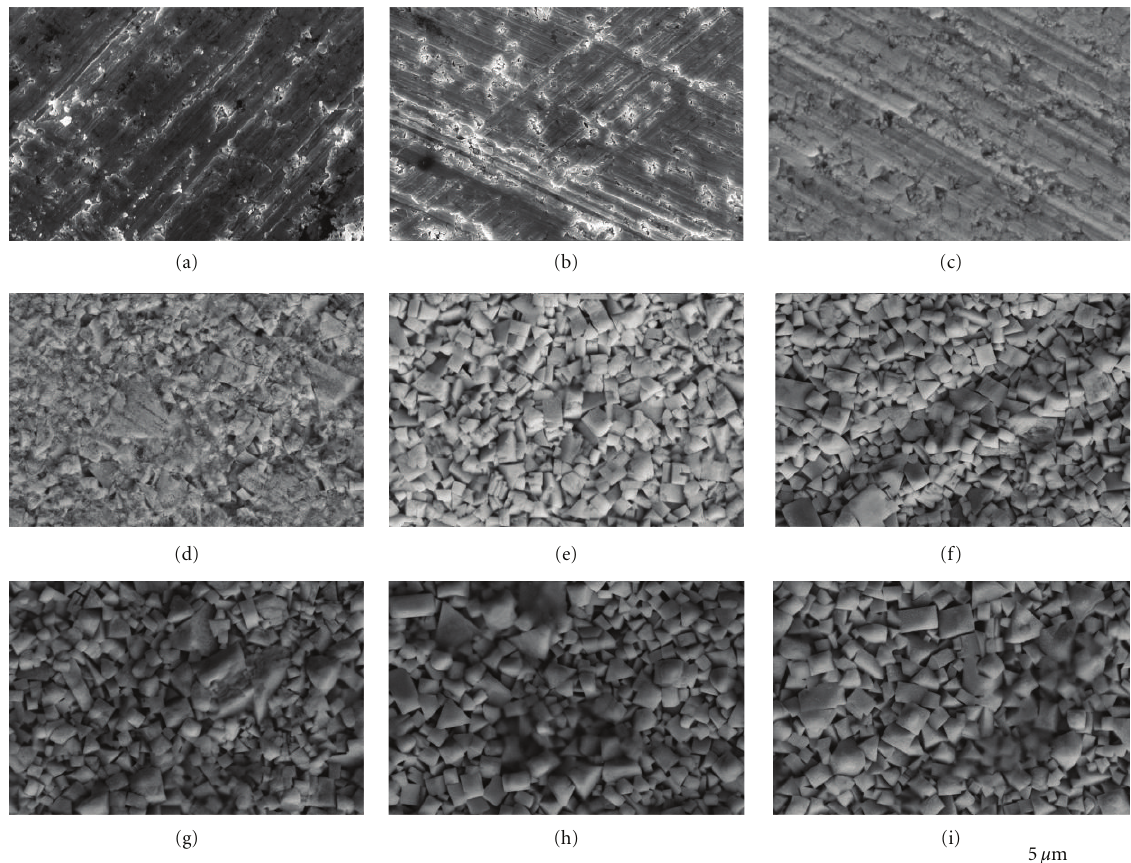
Figure 9: WC-Co substrate after and before laser processing: (a) as-received, (b) 600W, (c) 800 W, (d) 900W, (e) 1000 W, (f) 1100 W, (g) 1200 W, (h) 1300 W,(i) 1400 W.